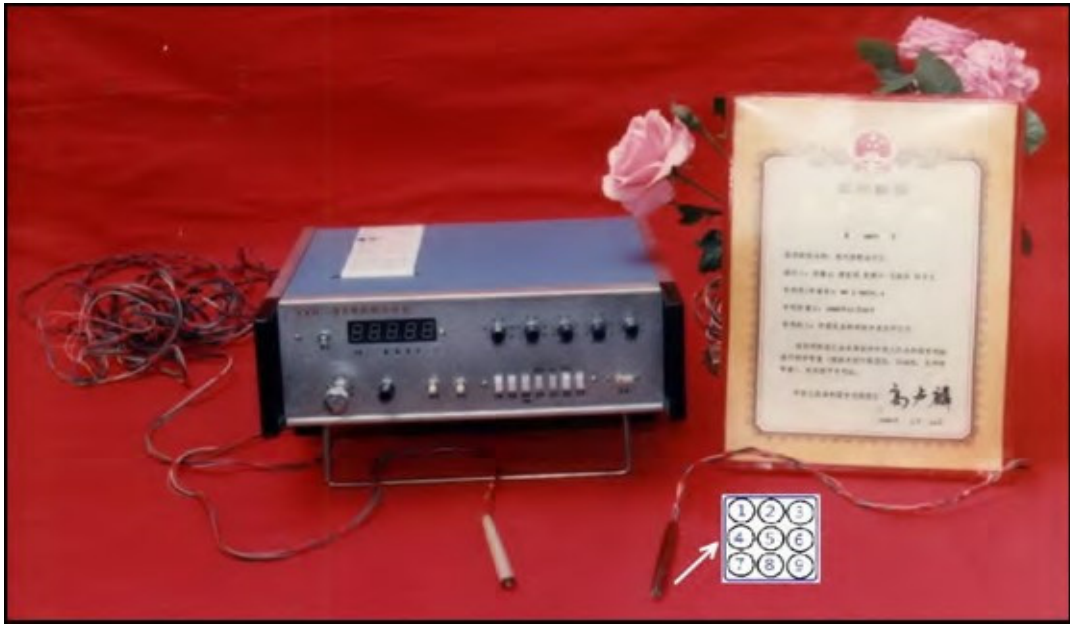
Figure 1. XXH-IIA Acupoint Diagnosis and Therapeutic Instrument used in this study; the white arrow points from the 1.5 cm diameter surface electrode probe to a diagram of the 9 sub-electrodes embedded in the probe head used to detect the area of lowest resistance within the acupoint; the probe on the left is the reference electrode; in this study an alligator clip electrode was used at the reference acupoint Wei-ben (used with permission).